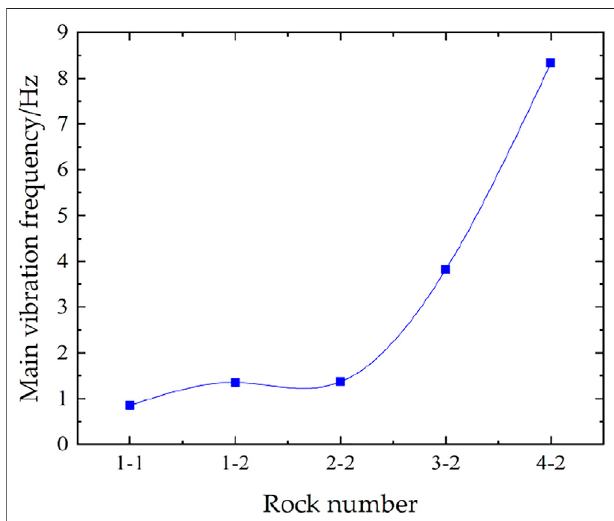
FIGURE 10 | Instantaneous Fourier frequency change